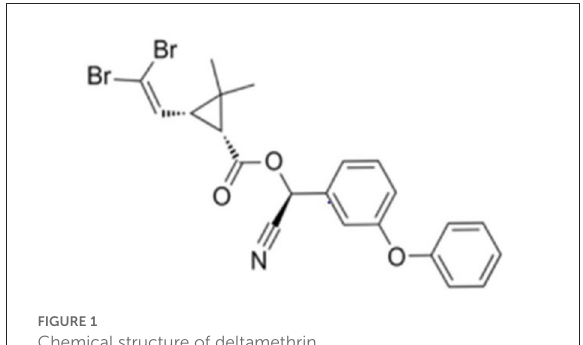
FIGURE1 Chemical structure of